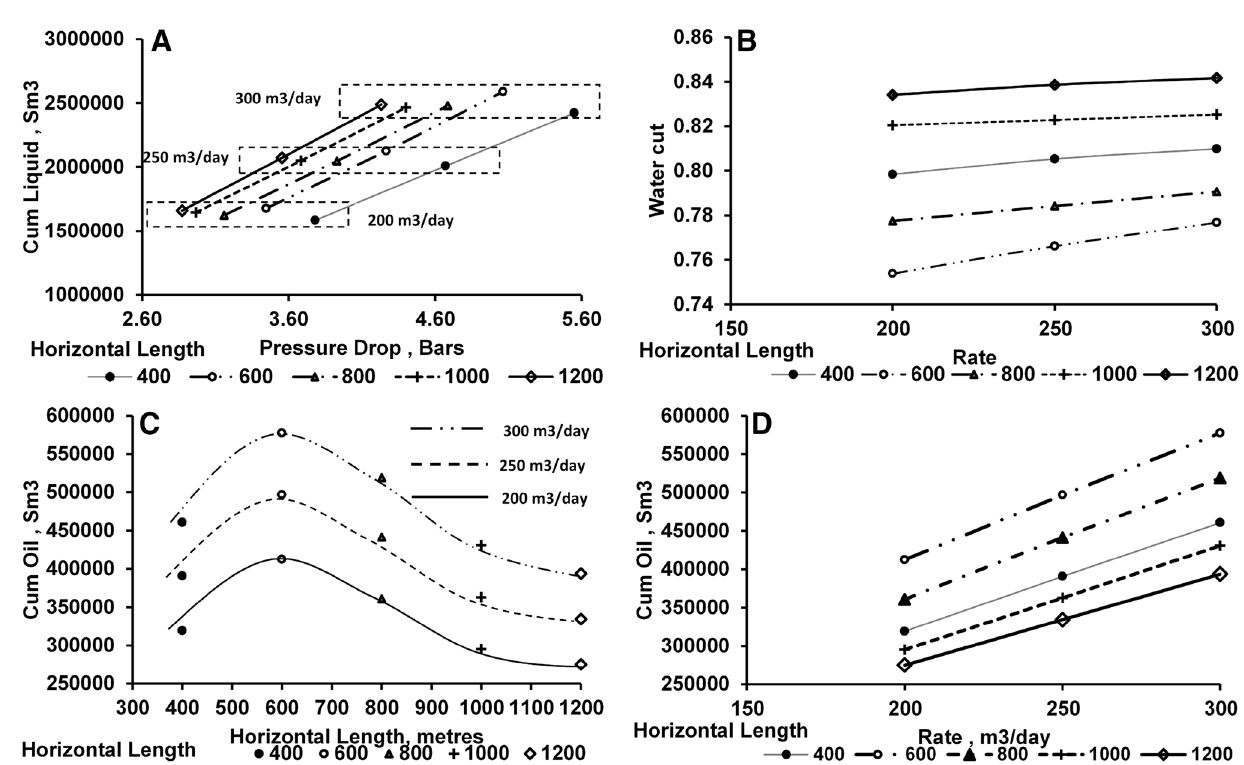
Fig. 9 Results of Group-1 simulation Figure 9b: As rate is increased from 200 to 300 m 3 /day, water cut increases for all horizontal lengths. Figure 9c, d: As assigned liquid rate is increased from 200 to 300 m 3 /day, cumulative oil production increases for all horizontal length sections examined. It can be seen that cumulative oil is maximum in case of 600 m horizontal length, which decreases on increasing hor- izontal length further.